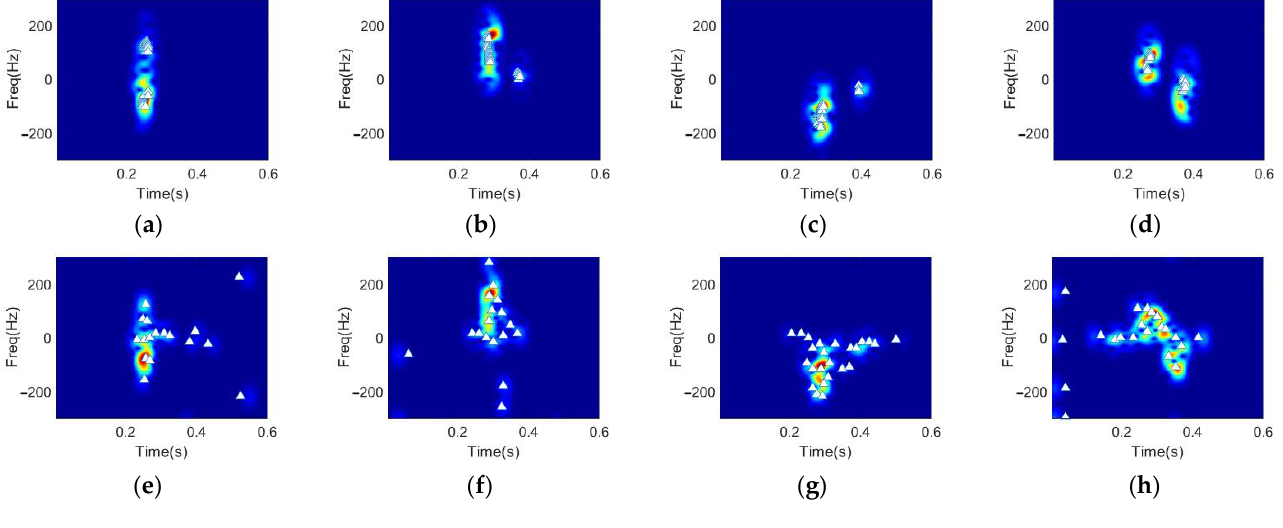
Figure 8. Demonstration of the feature vectors and the corresponding time-frequency distributions of the four hand gestures by DGS-SP: ( a – d ), and by OMP: ( e – h ), with K = 24.